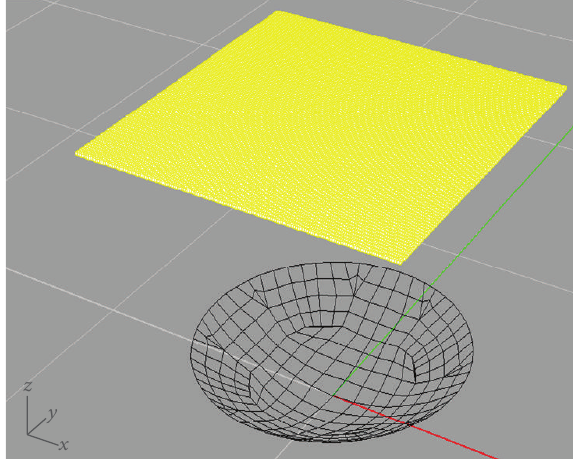
Figure 12: Observation surface sampled at 𝜆/3